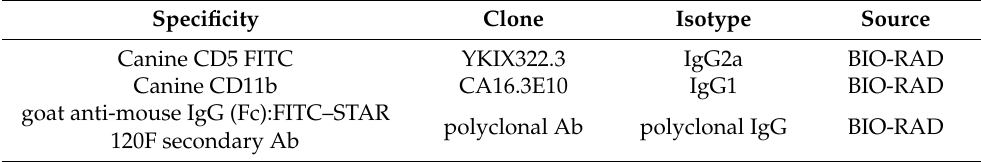
Table 3. List of antibodies used for surface phenotype